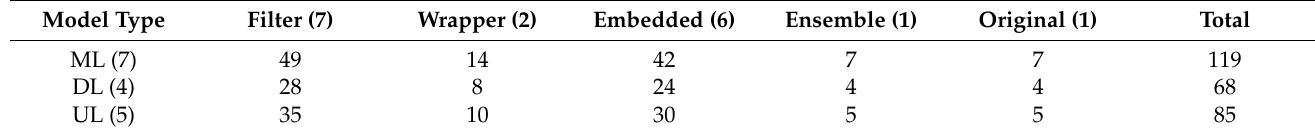
Table 4. Total number of models considered for performance evaluation.